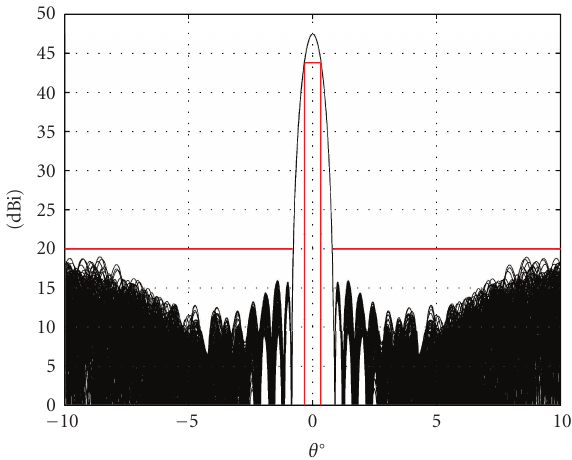
Figure 10: Array pattern for the configuration depicted in Figure 9. The beam is scanned to boresight. The red line corresponds to the requirement mask.